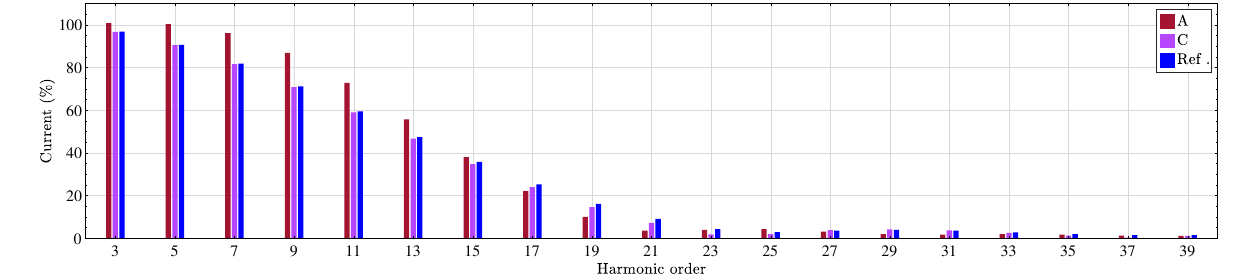
Figure 5. Comparison of current harmonics obtained from models A, C, and Ref for voltage source FT 2 and resistive-inductive system impedance ( Z 3 ).